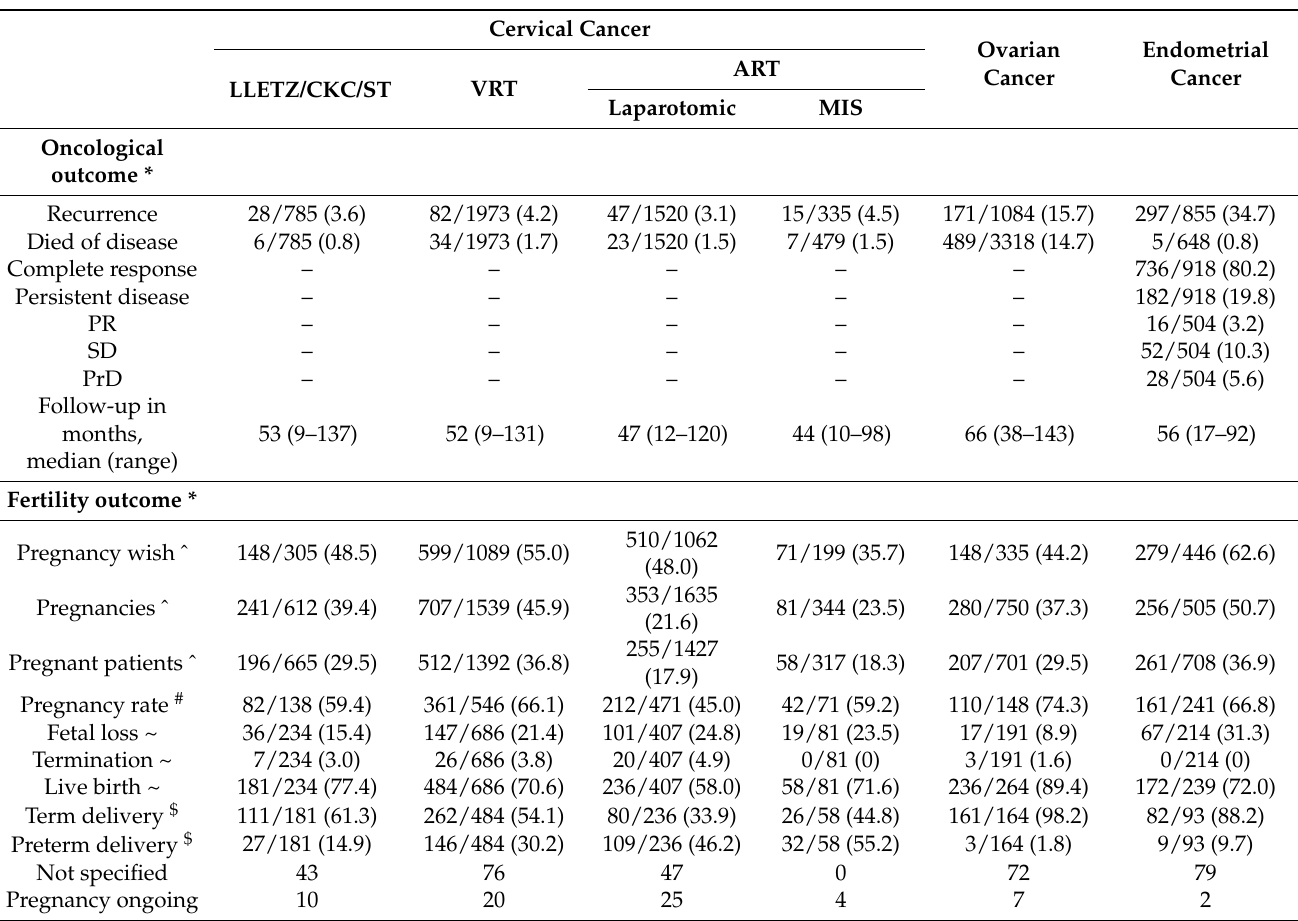
Cervical Cancer